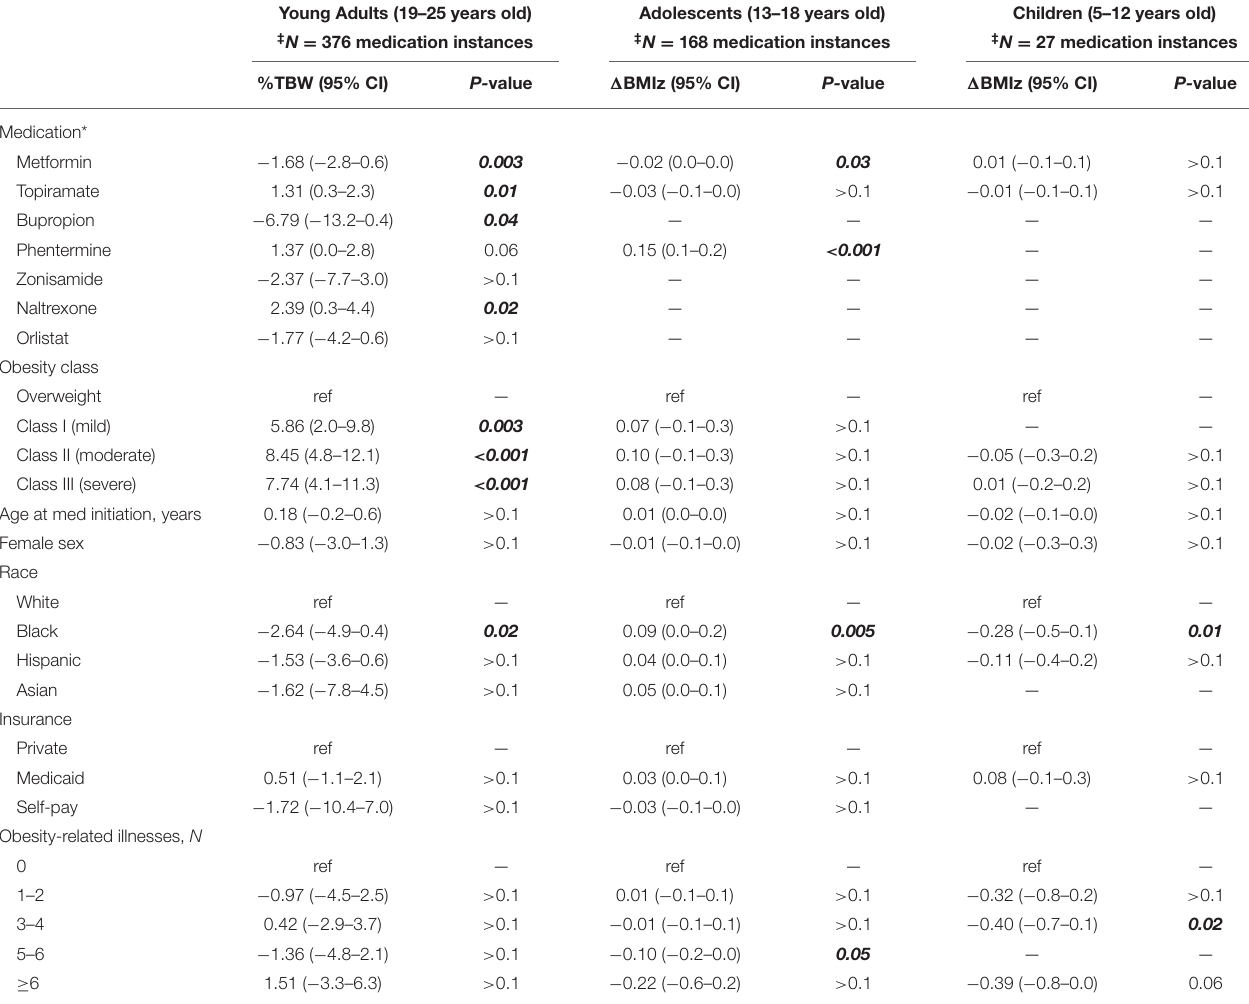
TABLE 10 | Effect on final weight loss, off-label patients—adjusted